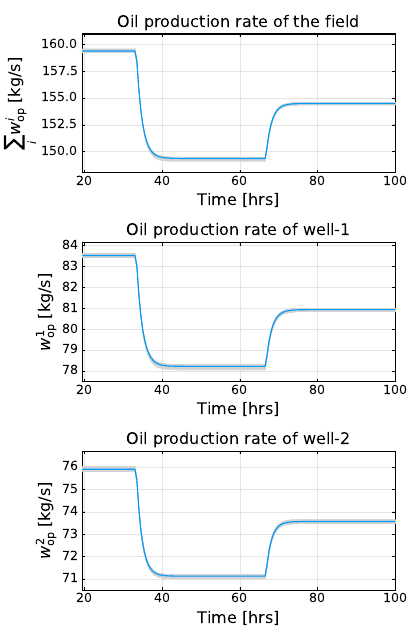
Figure 8: Data retrodiction of oil production (grey) vs. actual production